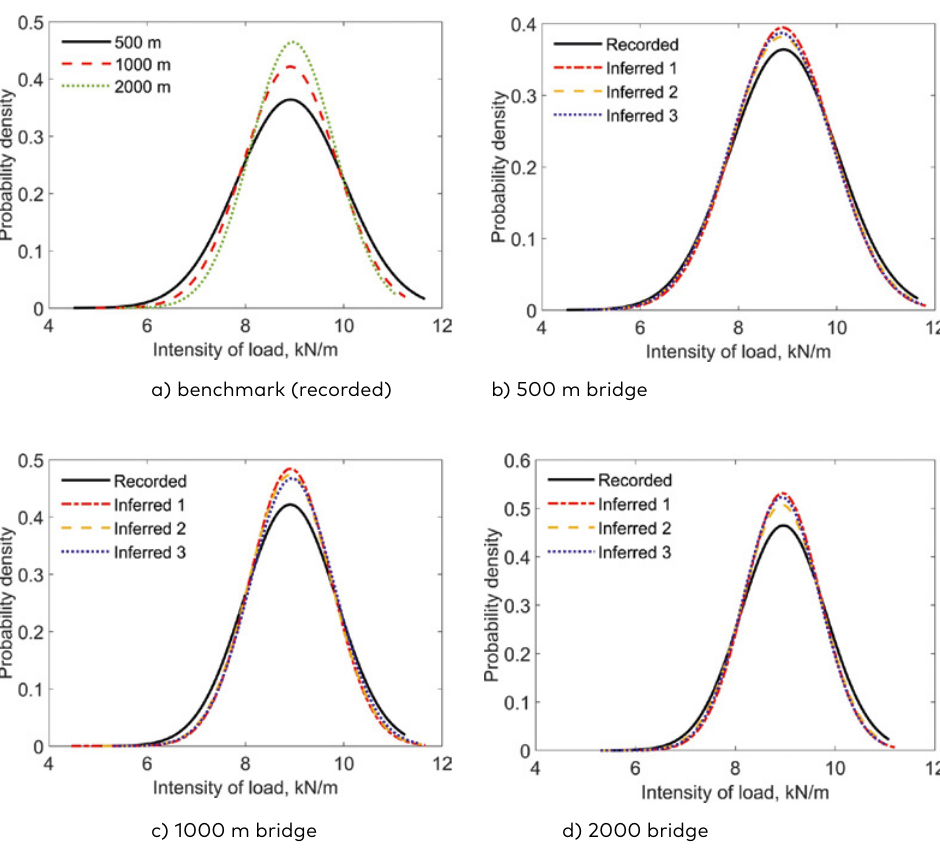
Figure 7. The probability distribution for the intensity of